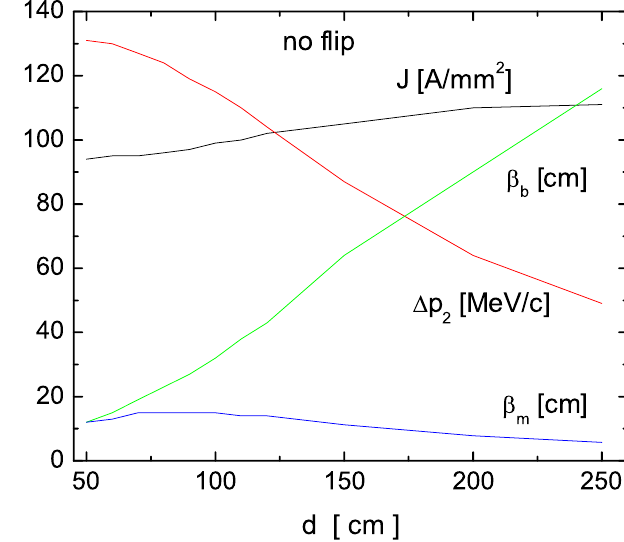
length for the no-flip case. The beta function at the cell boundary and midplane, momentum acceptance, and current density to fixed at 200 MeV =c are shown. The other parameter keep p 2 values were L (cid:2) 20 cm , a (cid:2) 40 cm , and t (cid:2) 24 cm . tance both fall. The beta function is much smaller at the midplane than at the cell boundary.